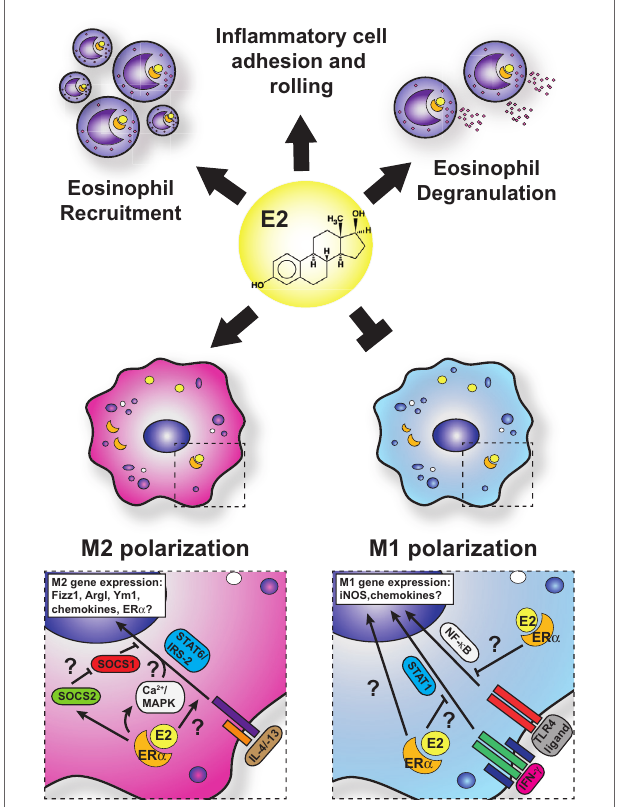
FiGURe 3 | Current model for estrogen signaling in polarization in macrophages in the setting of allergic lung inflammation . The general consensus is that estrogen enhances M2 polarization while suppressing M1-polarization in macrophage. However, mechanistic insights are lacking, and questions remain regarding the interface of ER α and IL-4